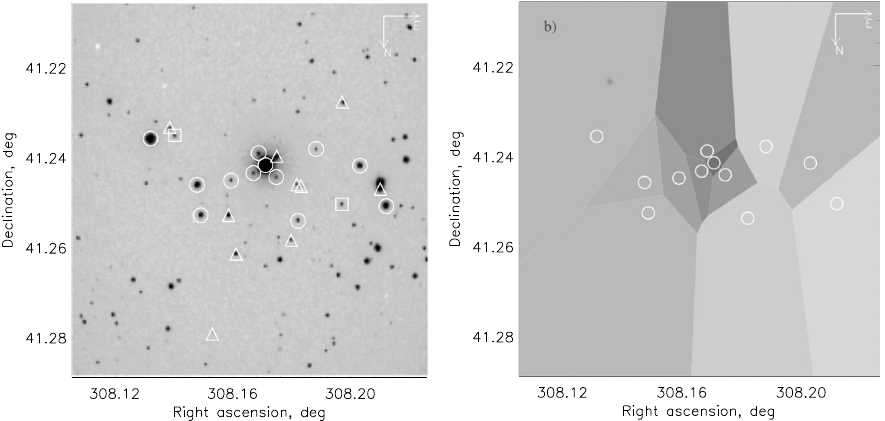
Fig. 1. Left: R -band image of the central part of Cyg OB2 in the vicinity of MT304 acquired with SCORPIO. The circles, triangles and squares mark the member, foreground and background stars, respectively. Right: Voronoi tessellated extinction map (one star per Voronoi cell) for twelve sample member stars (except for USNO-B1.0 1312-0389914) of Cyg